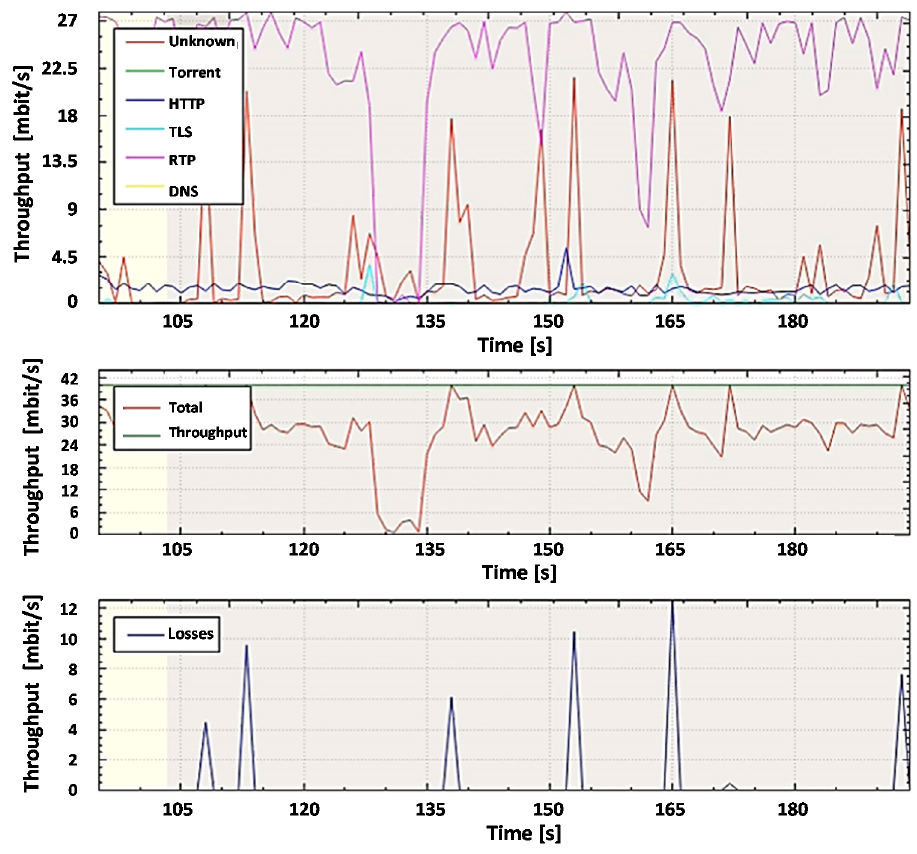
Figure 29. Throughput monitoring, in the transmission of legitimate and non-legitimate traffic (Non-Spoofed UDP Floods attack) using the proposed DPI system after anomaly blocking.